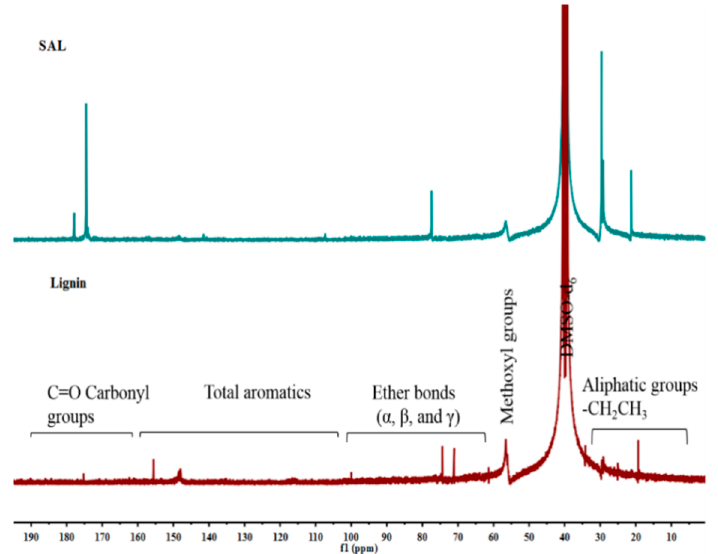
Figure 3. 13 C NMR spectra of lignin (S-lignin) and succinic anhydride-based lignin (SAL).